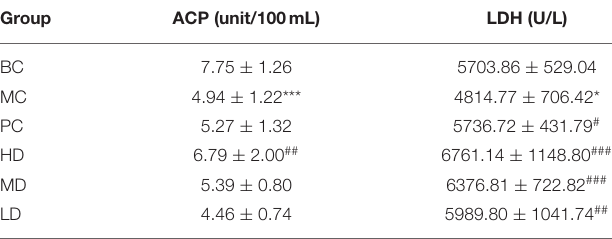
TABLE 2 | Effect of F. velutipes polysaccharide on serum ACP and LDH activity.